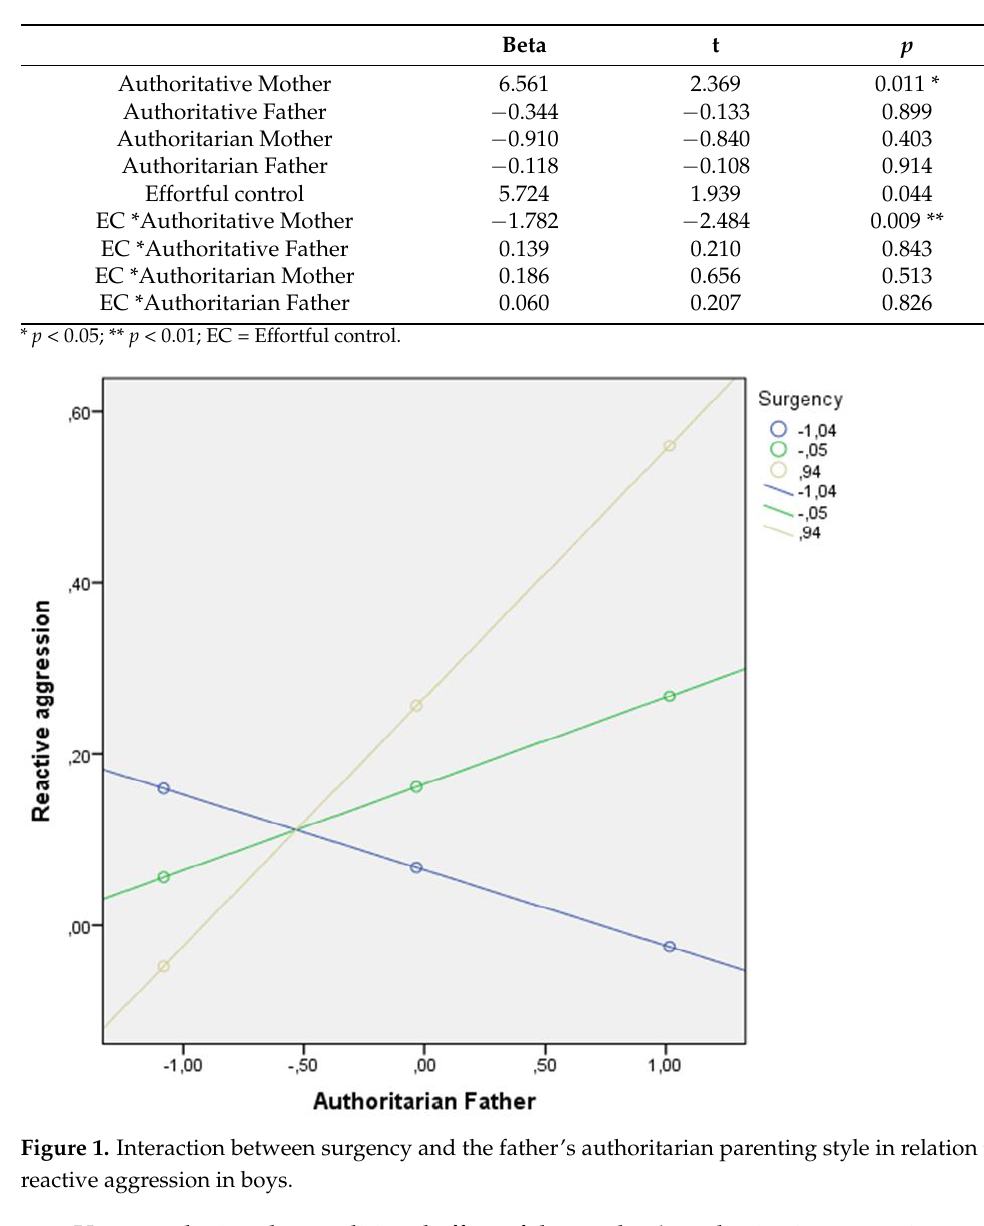
Figure 2. Interaction between behavioral inhibition and the mother ’ s authoritarian parenting style in relation to reactive aggression among boys.